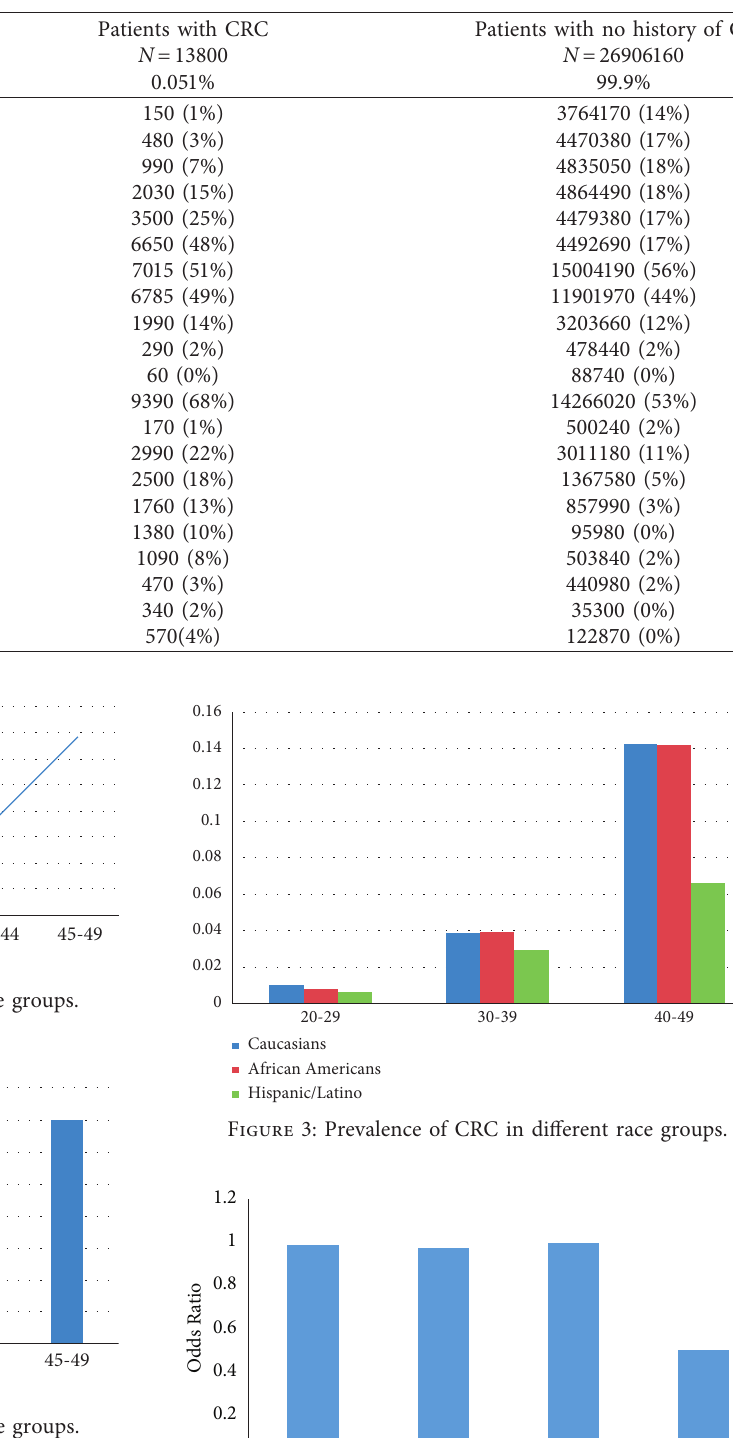
Table 1: Patients’ characteristics.